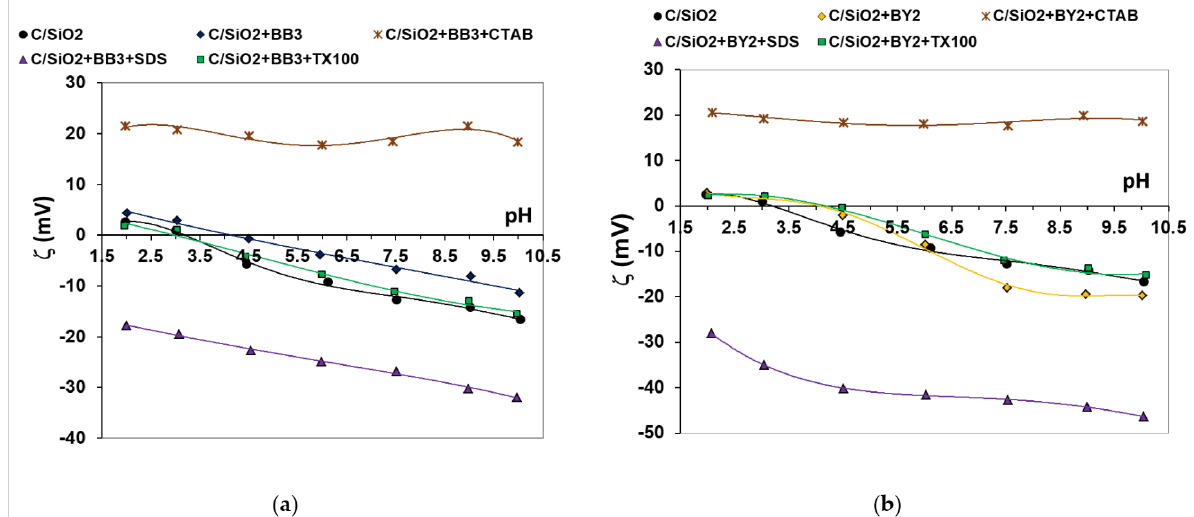
Figure 9. ( a ) Dependencies of the C/SiO 2 zeta potential vs. solution pH in the systems containing BB3 dye and surfactants with different ionic character; ( b ) Dependencies of the C/SiO 2 zeta potential vs. solution pH in the systems containing BY2 dye and surfactants with different ionic